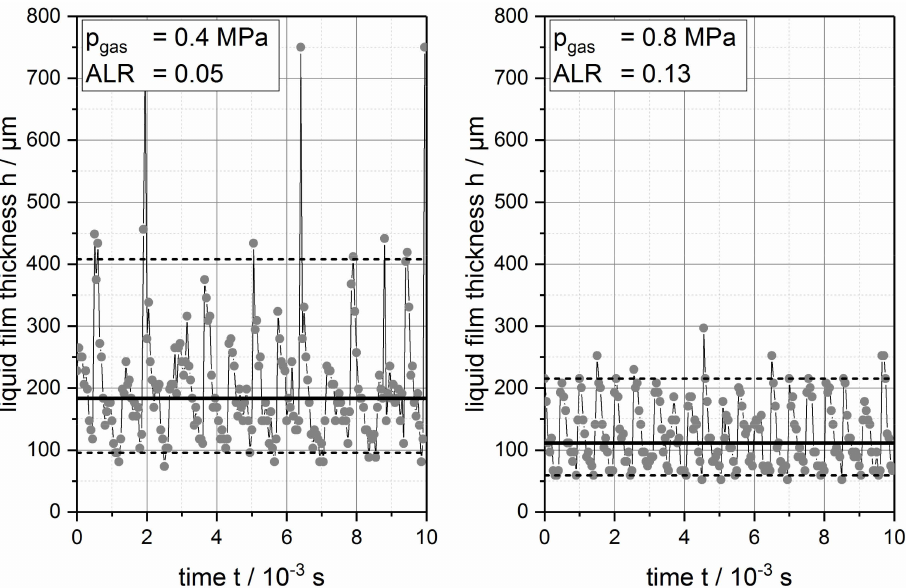
Figure 5. Time dependent liquid film thickness h (grey dots) for measurements at µ = 0.39 Pa · s and Q L = 40 L · h − 1 . Results at p gas = 0.4 MPa ( left ) and p gas = 0.8 MPa ( right ) are given. Additionally, x 5,0 (lower dashed line), x 50,0 (solid line) and x 95,0 (upper dashed line) of the liquid film thickness are given.